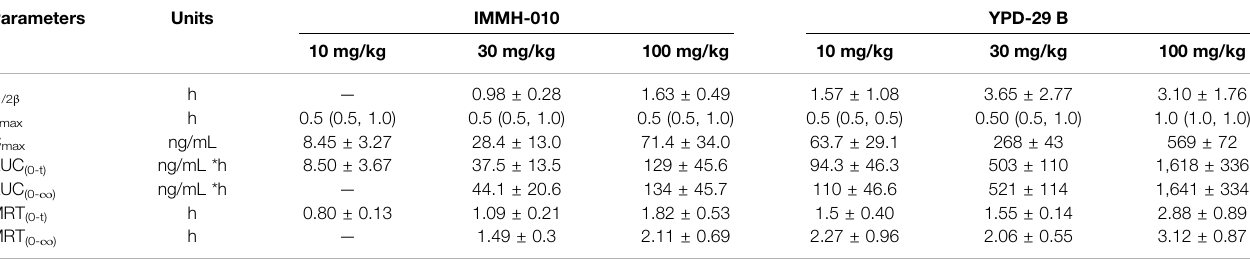
Frontiers in Pharmacology |